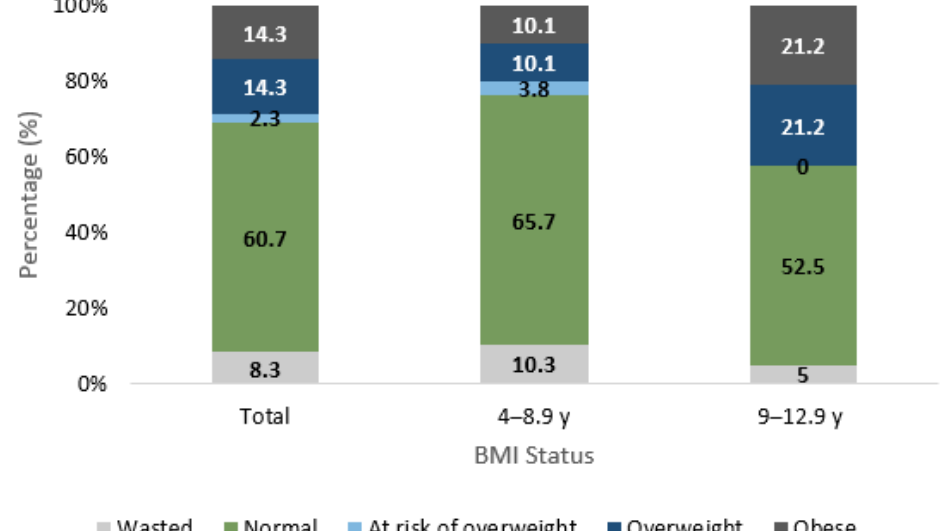
Figure 1. Anthropometric Characteristics of UAE Children Aged 4 to 12.9 Years Separated by Age, KNHS 2021. Significant difference in BMI status was observed between the two age groups with p < 0.001. At Risk of Overweight Status is only applicable to children below the age of 5 years.